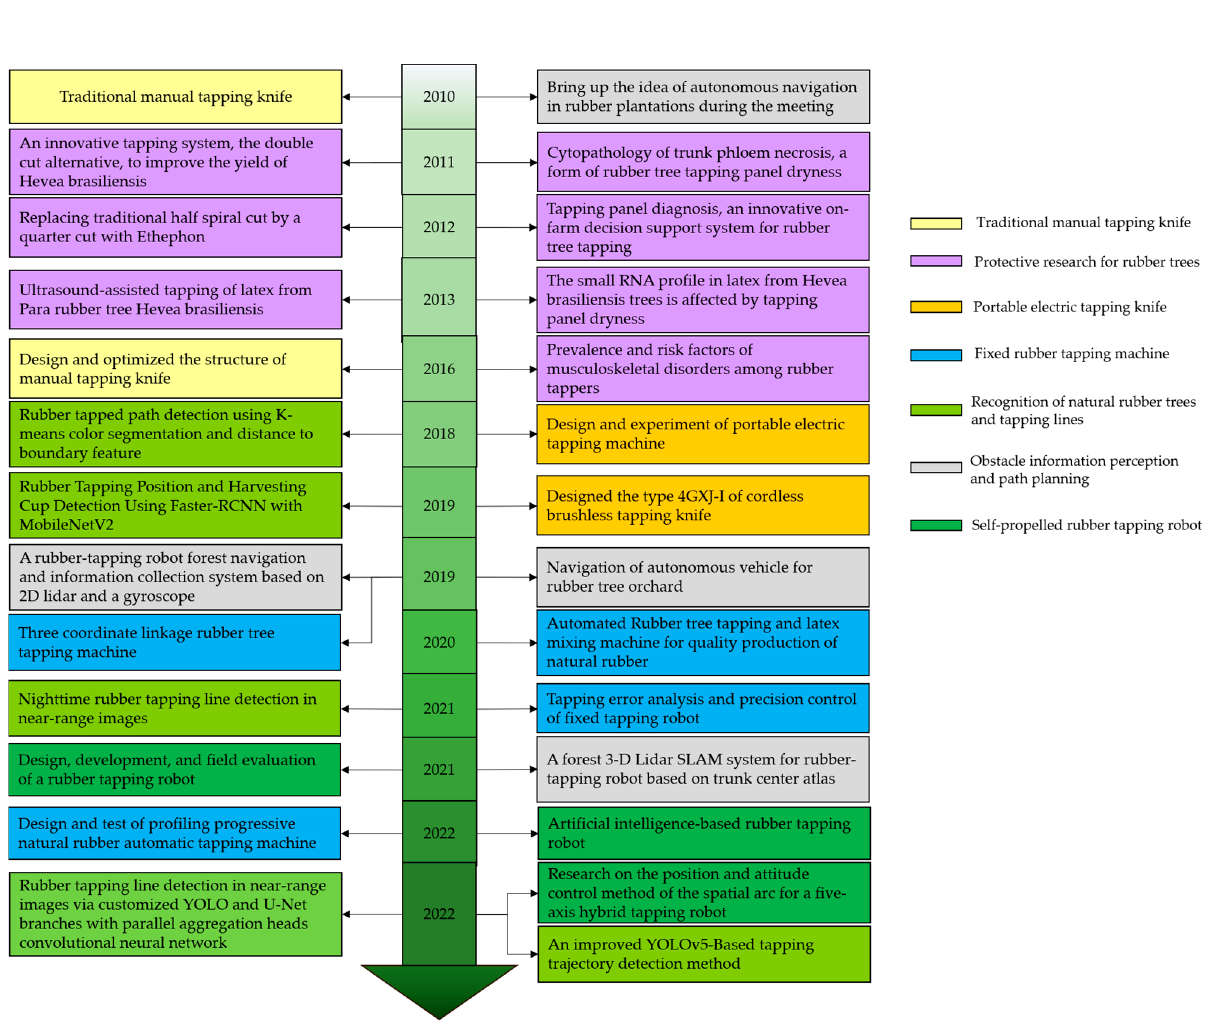
Figure 4. Diagram of the development of rubber tapping machines and the application of related intelligent technologies according to the research references.